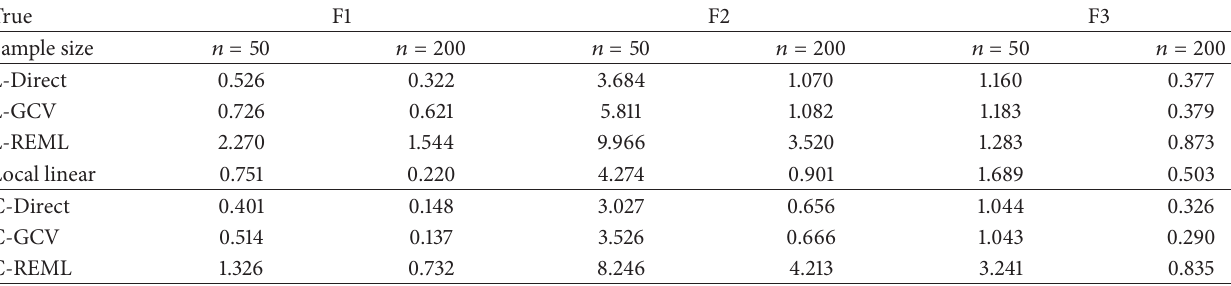
Table 1: Results of sample MISE for 𝑛 = 50 and 𝑛 = 200 . All entries for MISE are 10 2 times their actual values. True F1 F2 F3 Sample size